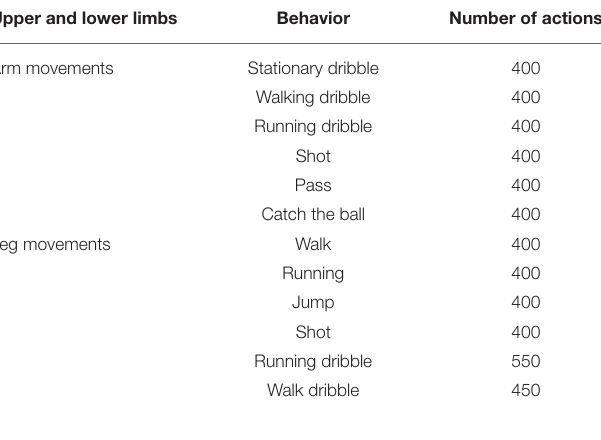
TABLE 2 | The number of different movements of the upper and lower